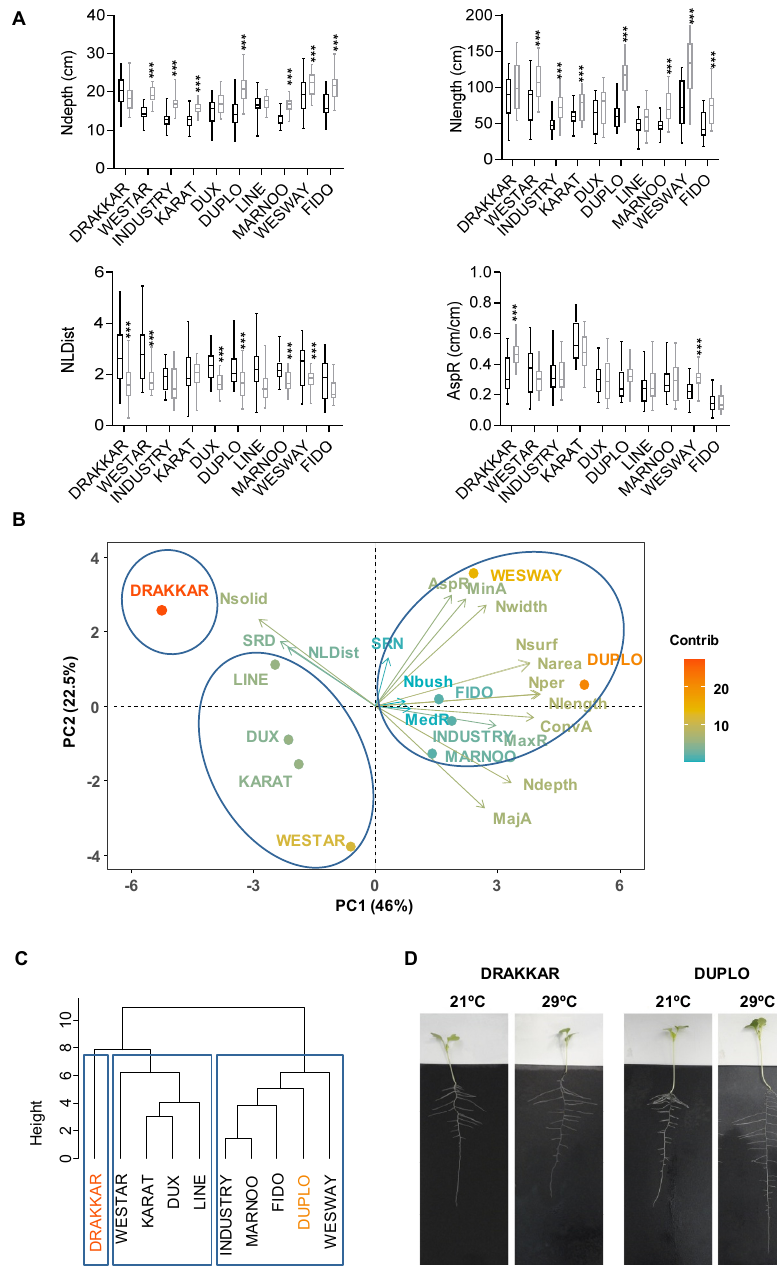
Figure 1. Differential RSA changes in B. napus varieties led to an increase in soil exploration in response to warm temperature. ( A ) Differential values of representative root trait categories: extent (network depth (Ndepth, cm)), size (network length, (Nleght, cm)), distribution (network length distribution (NLDist)), and shape (ellipse axis ratio (AspR), cm cm − 1 ) traits of a collection of 10 spring oilseed rape genotypes grown at 21 ◦ C and 29 ◦ C. Statistical t -test analysis, *** FDR < 0.01. ( B ) Biplot of principal component analysis (PCA) based on all root traits analyzed, showing the high contribution of size and shape traits to variability of SOSR genotypes. Traits and varieties are colored based on contribution to the variance. Circles highlight the three different groups based on their root response to warming. ( C ) Dendrogram plot of SOSR genotypes. AGNES (agglomerative nested) hierarchical clustering was used, where Y -axis represents (dis)similarity based on Ward’s minimum variance method. Color boxes highlight three main clusters according to their root trait values. ( D ) Representative root organization of Drakkar and Duplo Brassica napus varieties grown in a pouch-and-wick system for 7 days at 21 ◦ C or 29 ◦